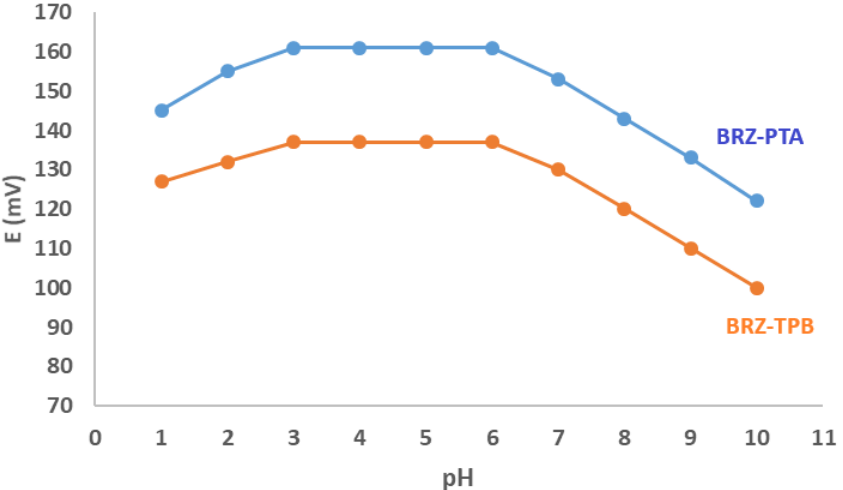
Figure 3. Effect of pH on the potential response bromazepam-phosphotungstate (BRZ-PTA) and bromazepam-tetraphenyl borate (BRZ-TPB membrane sensors.